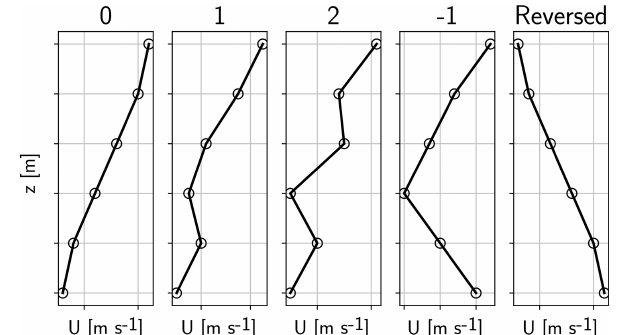
Figure 1. Possible vertical wind profile categories when categoriz- ing according to the number of local maxima at a site with six mea- surement heights. Titled according to the number of maxima.